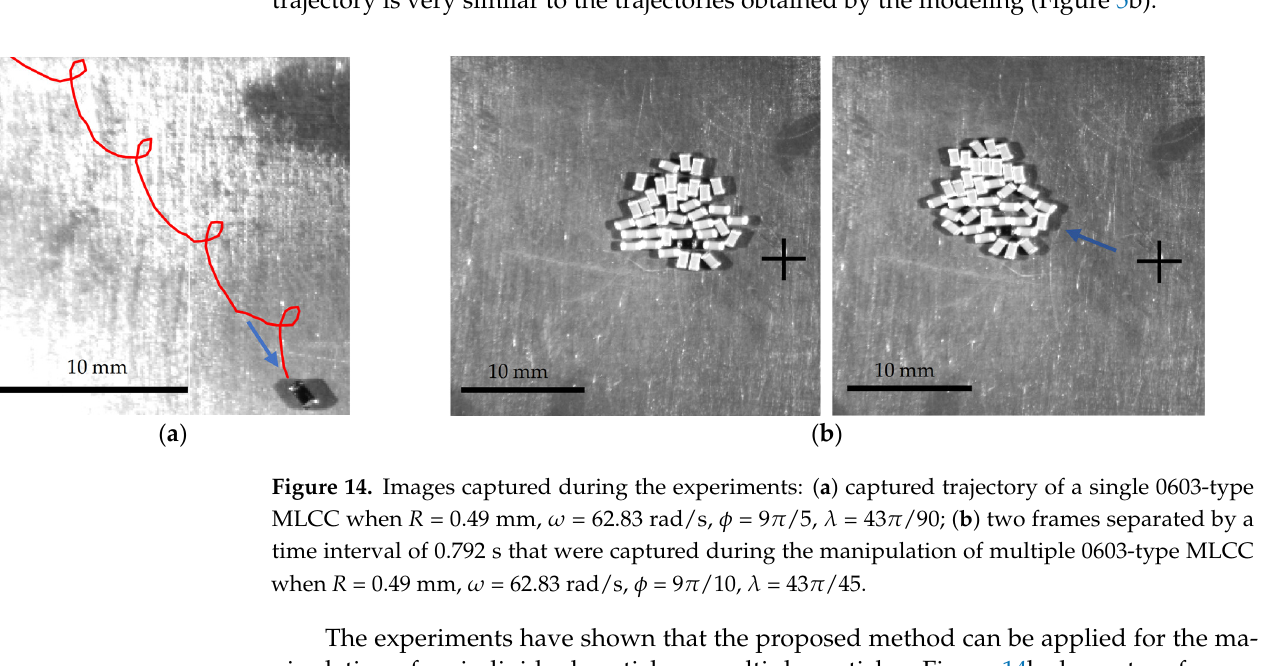
Figure 13. Experimental results of α depending on the following: ( a ) ϕ when R = 0.49 mm, ω = 62.83 rad/s; ( b ) λ when R = 0.49 mm, ω = 62.83 rad/s.